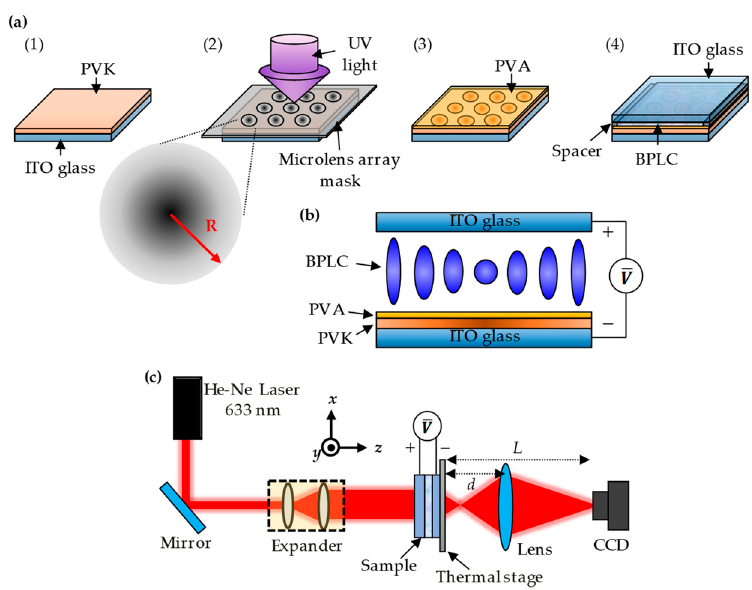
Figure 1. Schematic presentations of ( a ) the main production procedures of the sample: ( 1 ) PVK spin-coated; ( 2 ) UV exposure; ( 3 ) PVA layer assisted on the PVK film; ( 4 ) sample assembly; ( b ) a non-linear gradient of the LC orientation in the sample and thus the GRIN lens effect under an applied voltage; ( c ) the experimental setup for measuring the focal length of the BPLC microlens array.